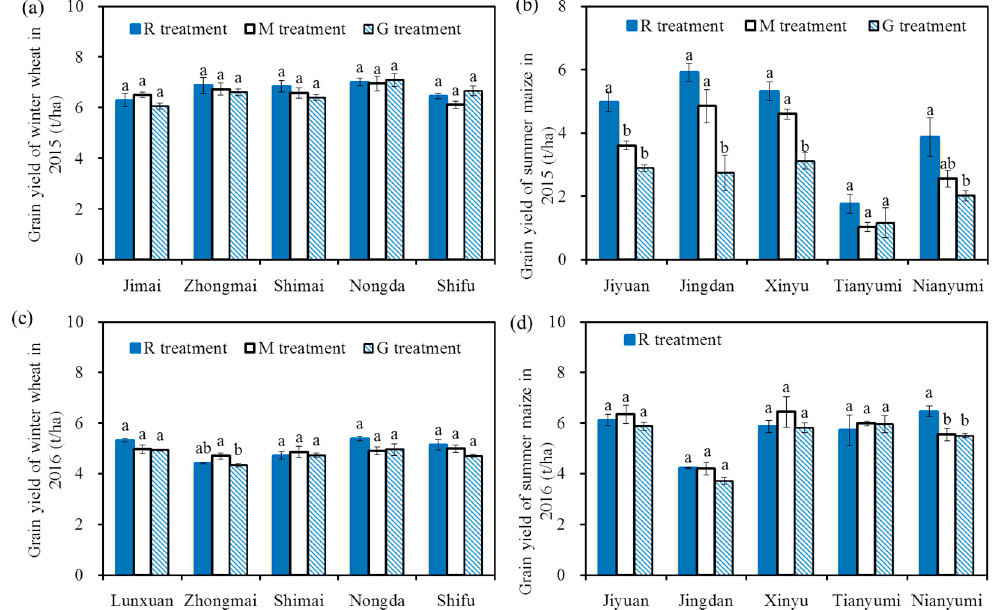
Figure 4. Grain yields of winter wheat and summer maize in 2015 and 2016, grain yields of winter wheat in 2015 ( a ); grain yields of summer maize in 2015 ( b ); grain yields of winter wheat in 2016 ( c ); grain yields of summer maize in 2016 ( d ). The grain yield of summer maize ranged from 1.03 to 6.46 t/ha. The values in 2015 were lower than the results reported by Qiu et al. (2012) [45] and Liang et al. (2013) [46], who found that the grain yields of summer maize were 5.2~9.0 t/ha with efficient water and N supplies. The main reasons for these results may be the different climate and varieties. The grain yields in the R treatment were significantly higher than those in the G treatment for each variety in 2015 ( p < 0.05, except for Tianyumi), and there were no significant differences among the three treatments for each variety in 2016 ( p > 0.05, except for Nianyumi). The relatively higher grain yields in the R treatment compared with those in the G treatment in 2015 may be due to a better growth state in the R treatment (e.g., height and leaf area, Figure 3), and the similar grain yields among the three treatments for each variety in 2016 may be due to a similar growth state (Figure 3). The reasons for the higher maize grain yield and the small effect of reclaimed water on grain yield in 2016 may be due to the relatively higher precipitation in the summer maize season in 2016 (300 mm in 2015, 510 mm in 2016), indicating that the effects of reclaimed irrigation water on summer maize yields were influenced by climate. Note: Different letters on the top of the histogram indicate significant differences among the three treatments for each variety ( p < 0.05).